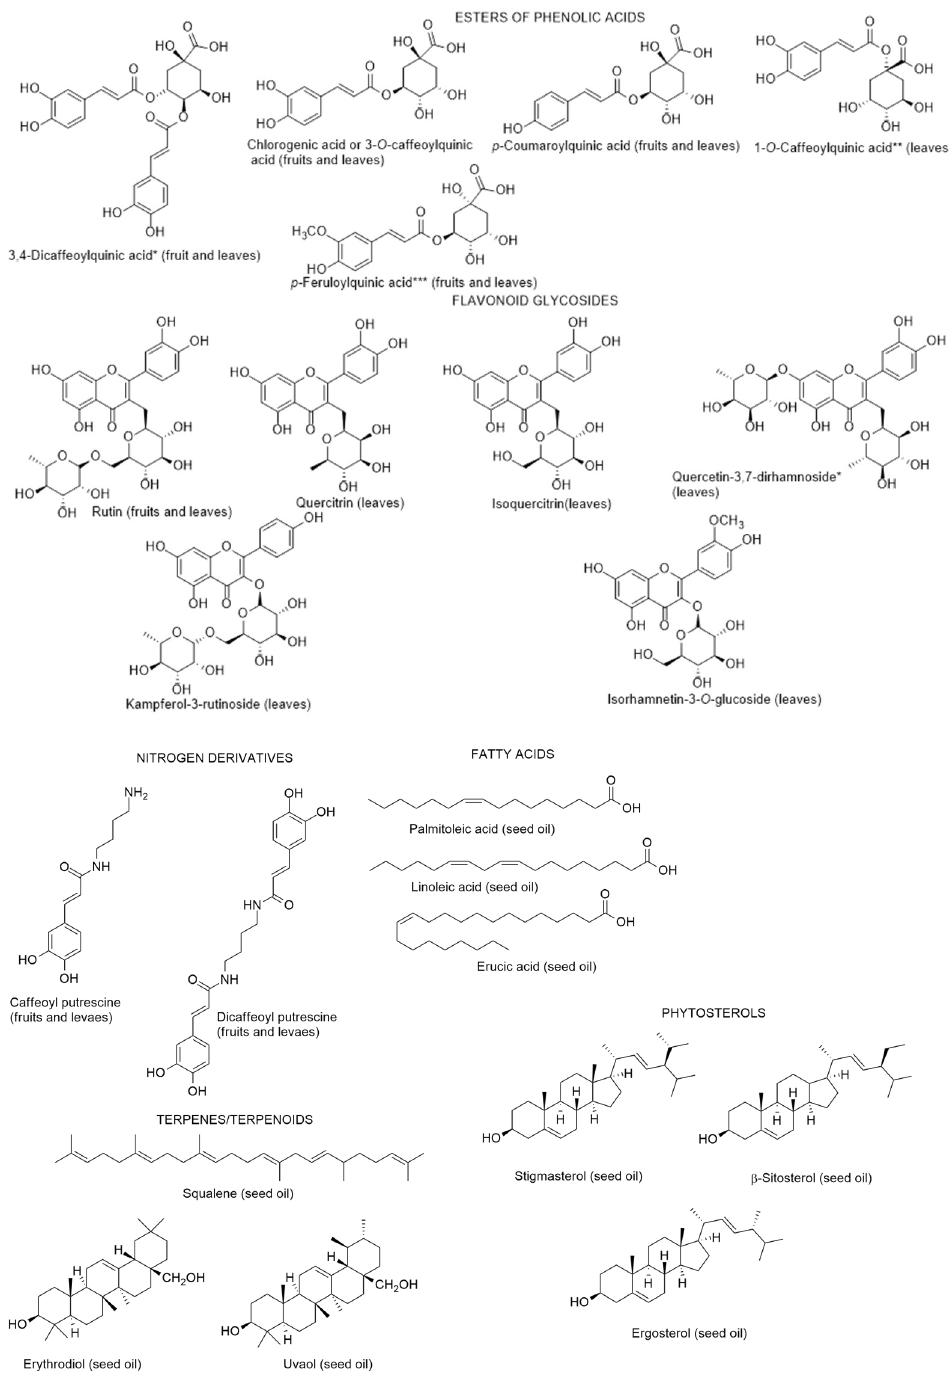
Figure 7. Metabolites found in different parts of Lycium intricatum . *, **, *** The isomers were not reported by the authors [99], therefore, the compounds represented are examples and not the isomers identified.